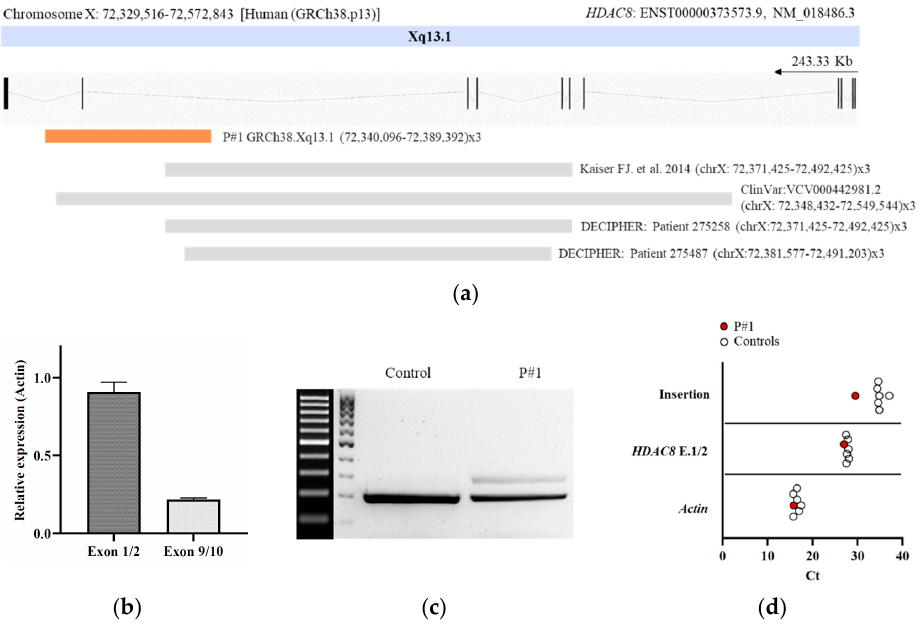
Figure 2. Molecular characterization of the intragenic duplication in HDAC8 . ( a ) Schematic representation of intragenic duplications on HDAC8 related to CdLS reported to date. The genomic region duplicated for each case is shown. Localizations of duplications on HDAC8 are indicated by chromosome band and position (human (GRCh38.p13)). The arrow indicates the direction of transcription. The region duplicated in the patient is marked by an orange-filled box; ( b ) qPCR analysis of exons 1–2 and 9–10 of HDAC8 (NM_018486.3). Gene expression levels were normalized to actin.